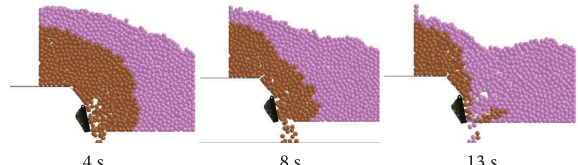
Figure 8: Interface morphology of coal gangue at diferent time periods.